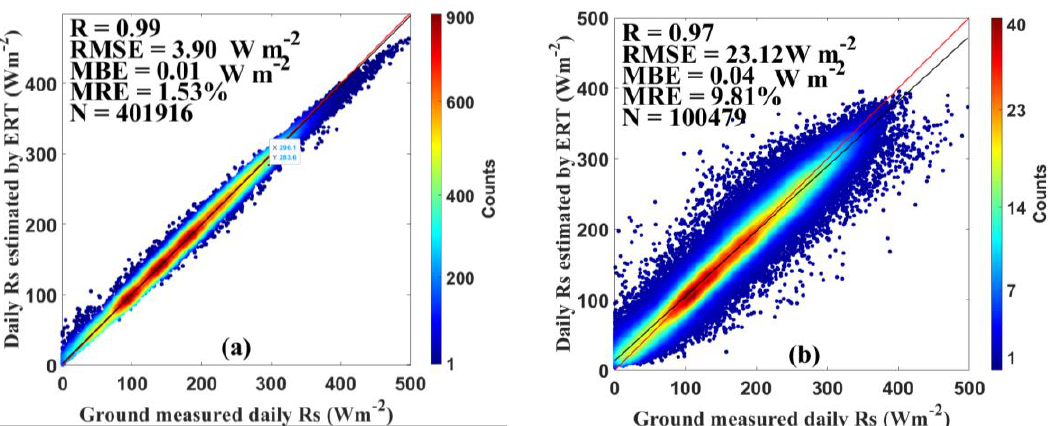
Figure 2. Evaluation results of the extremely randomized trees (ERT)-based model for the ( a ) training dataset and ( b ) test dataset against ground-measured Rs during 2000–2015. Table 1. Training and test results of the ERT-based model.